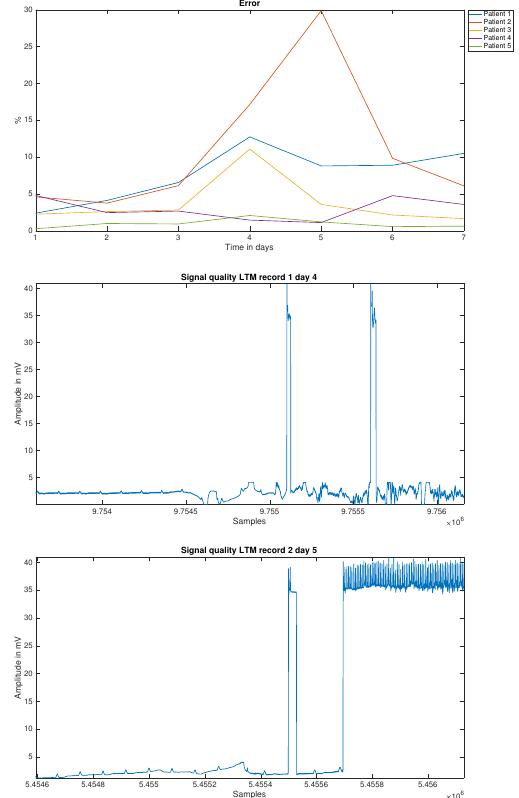
Figure 8. Evolution of the detection error for each LTM patient across the test duration ( up ), and examples of noise types present in 7-day Holter recordings ( middle and down